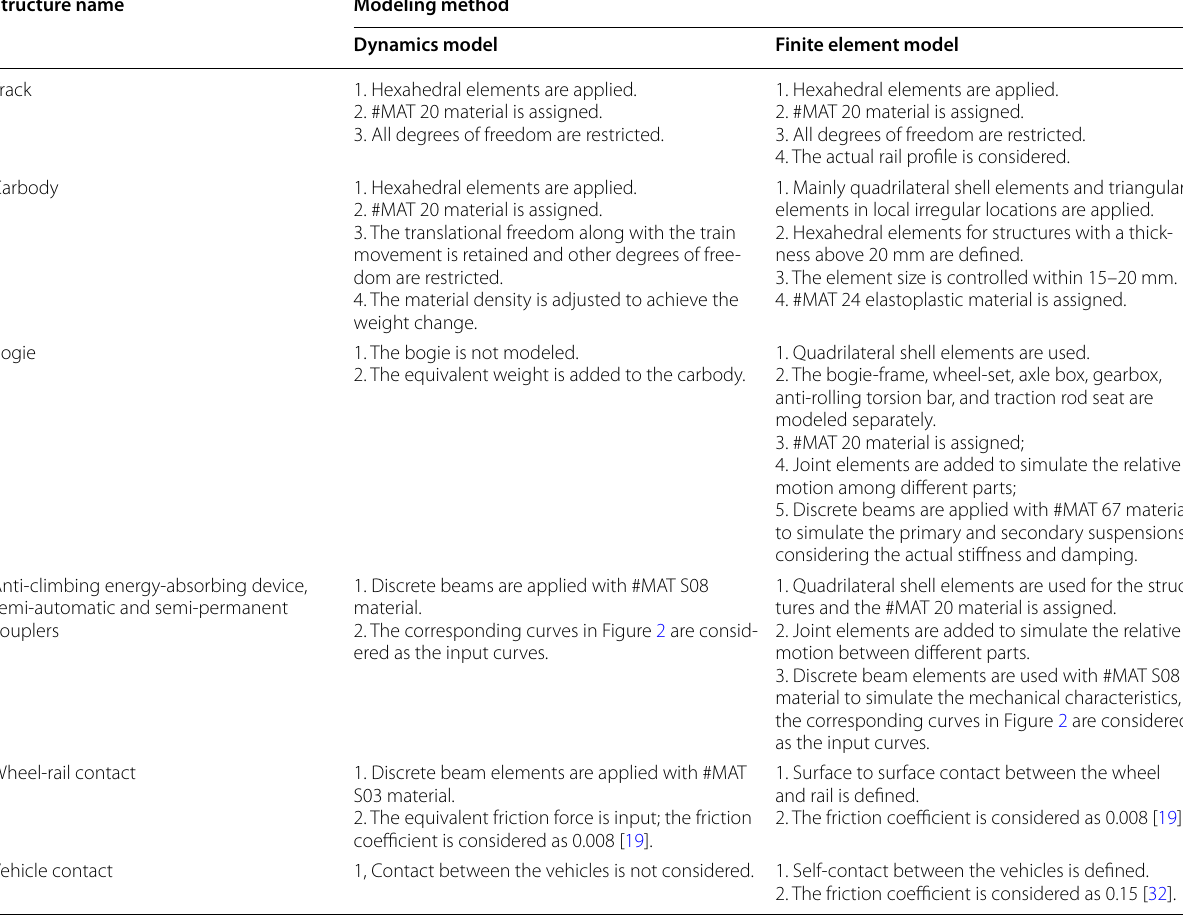
Table 1 Comparison between the modeling methods used for the train collision